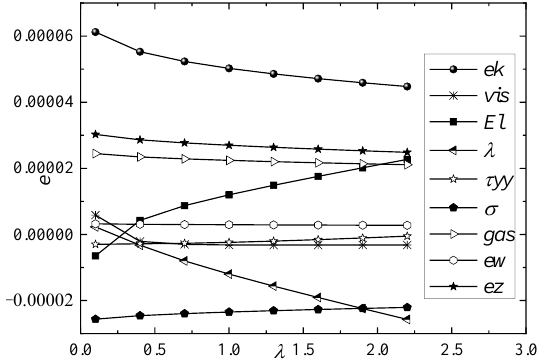
Figure 11. Effect of time constant ratio on rate of change in the kinetic energy and other forces.